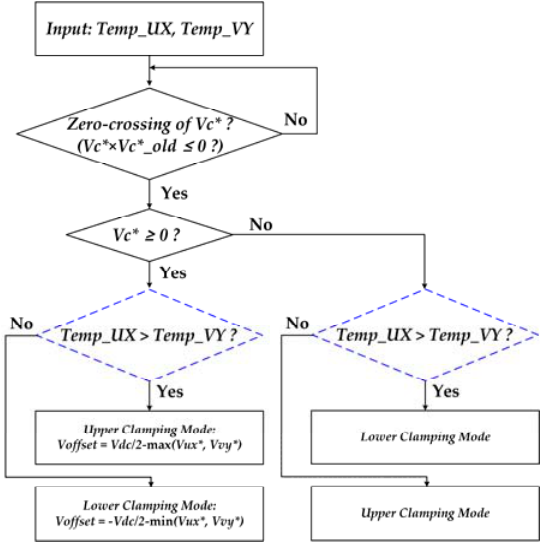
Figure 10. Clamping mode selection procedure according to power stack temperatures.